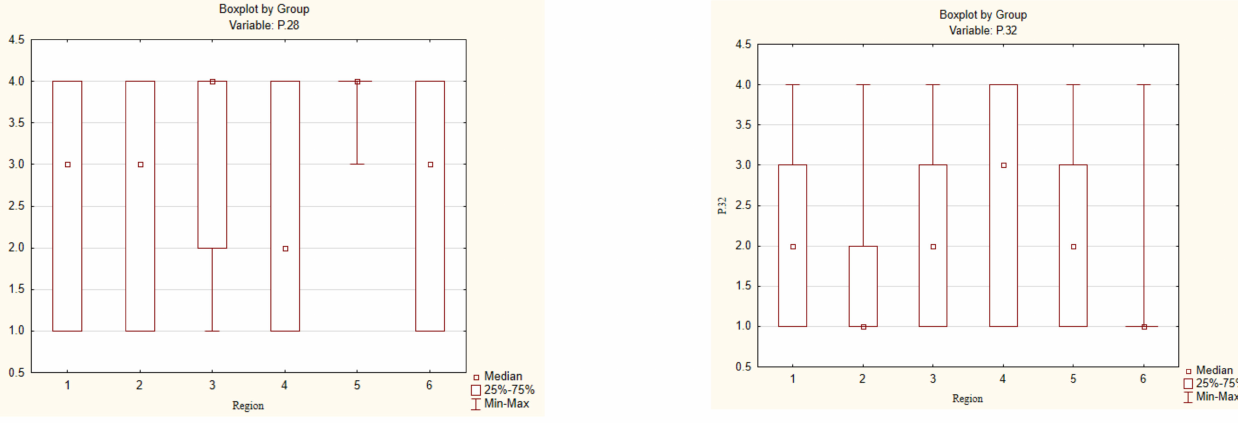
Figure 11. Box and whisker diagrams by practices P28 (Using own cup), P32 (Composting kitchen garbage), from the categories “No plastic” and “Waste